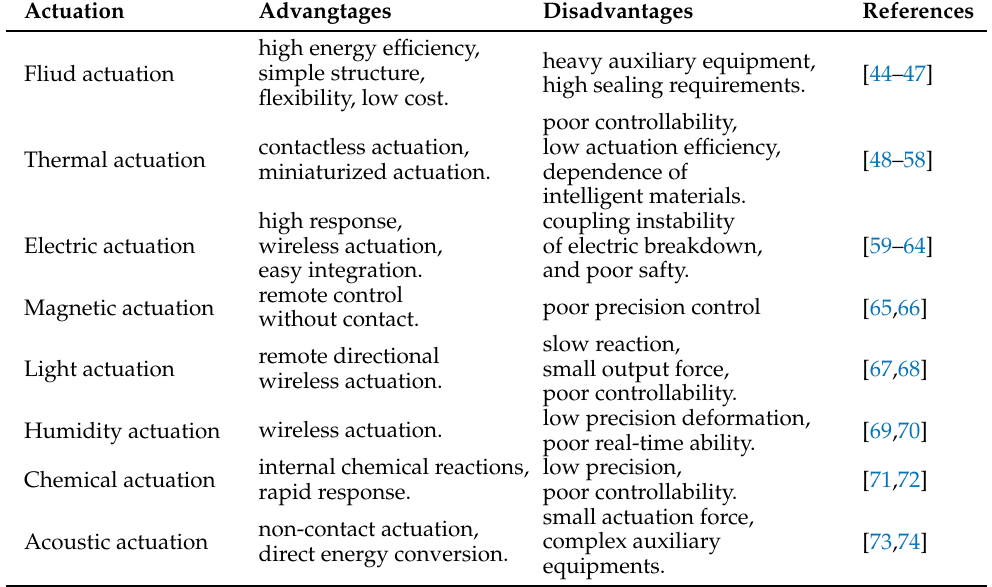
Table 1. Advantages and disadvantages of various actuation